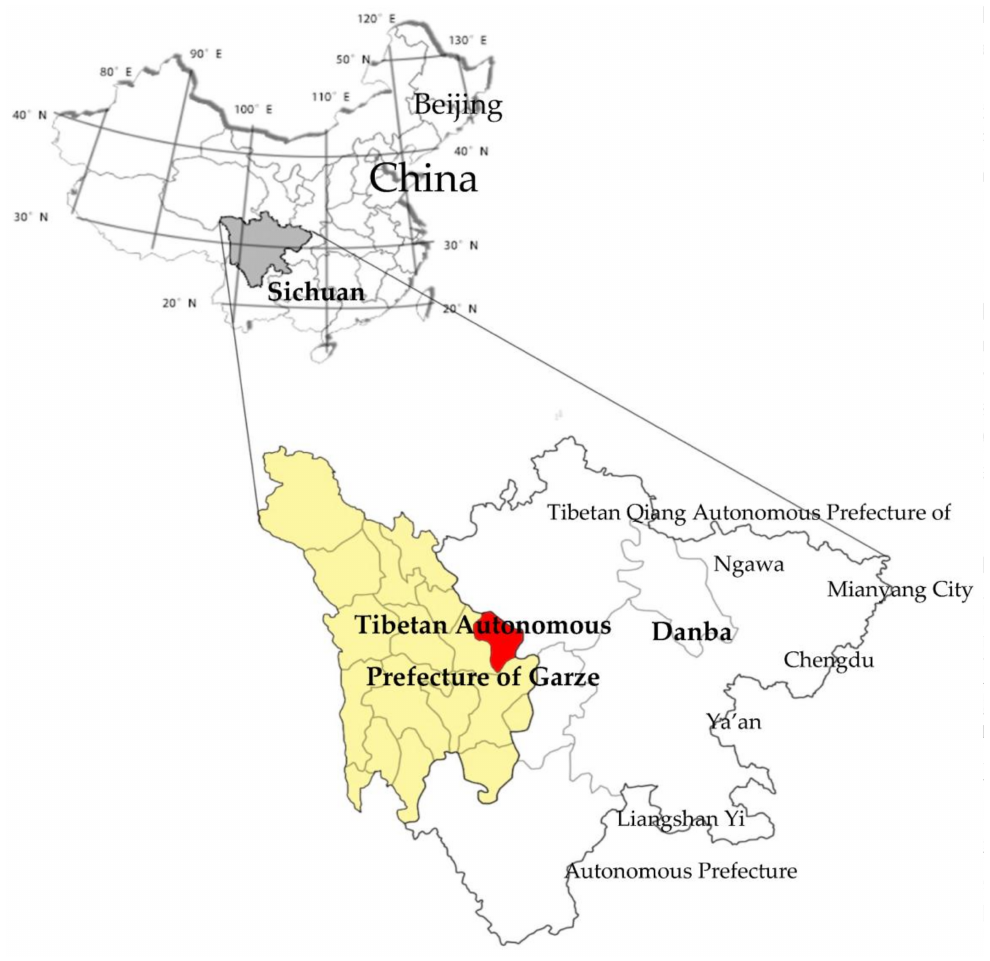
Figure 1. Map of location of the studied